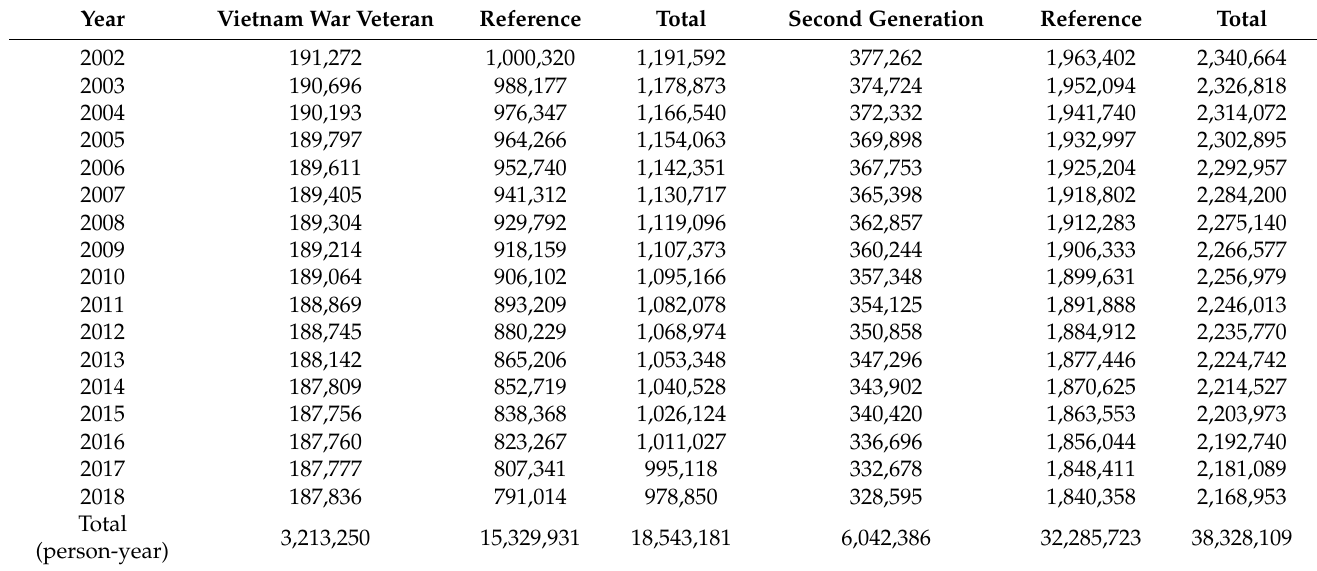
Table 2. Distribution by year of the Vietnam War veteran and second-generation cohort during follow-up period.